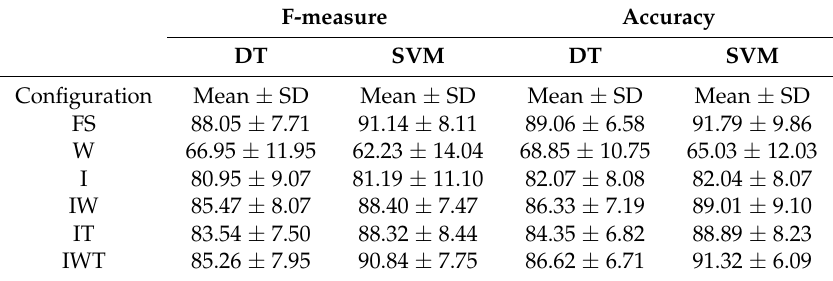
Table 3. Average F-measure (%) and accuracy (%) of LOSO analysis with standard deviation (SD). F -measure